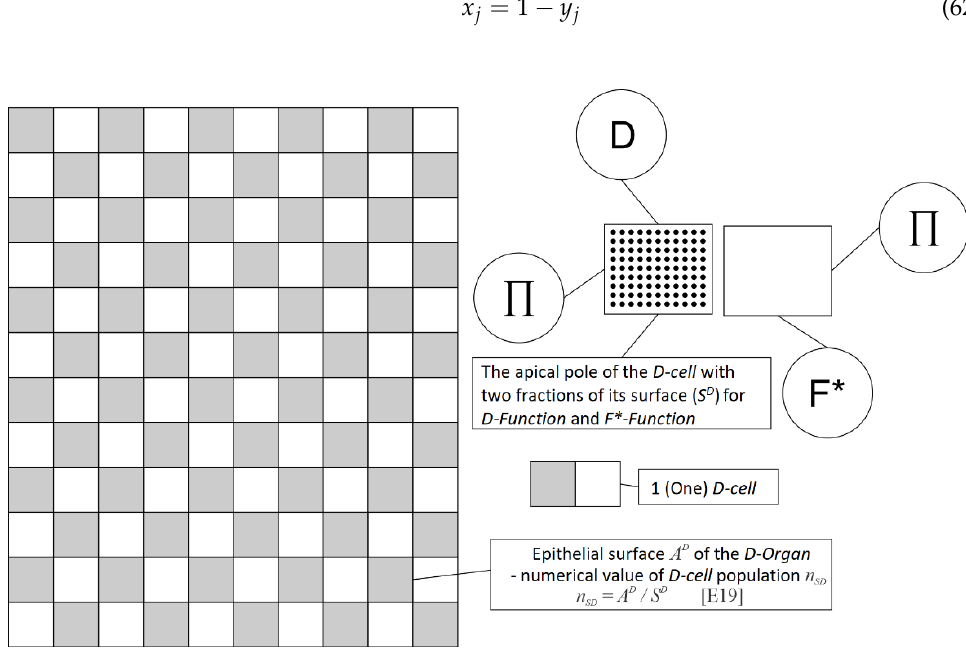
Figure 4. Explanation of the significance on numerical values for the Π fraction .